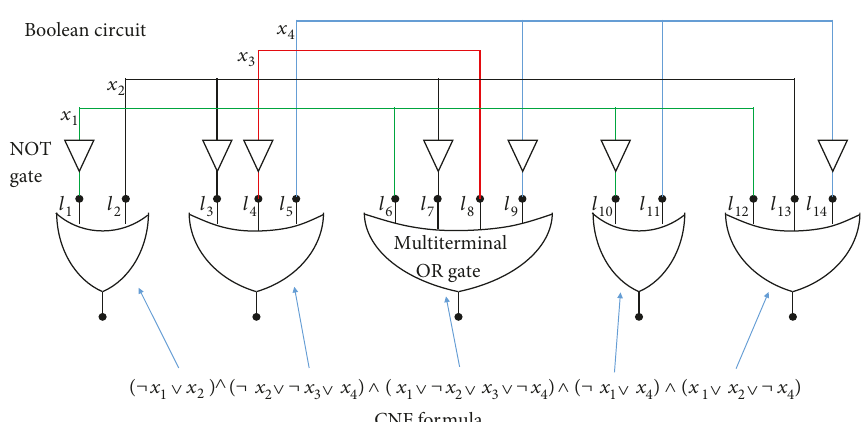
Figure 1: Example of the mapping between a Boolean satis fi ability formula in conjunctive normal form and a Boolean circuit made of multiterminal OR and NOT gates. Each clause of the SAT formula is mapped into an OR with as many terminals as the literals in the clause (the satis fi ability of this multiterminal OR requires that at least one terminal has a truth value of 1). The global optimum of the SAT formula, that is, the maximum number of satis fi ed clauses, corresponds to the maximum number of OR gates with output one. This Boolean circuit is then transformed into a self-organizing logic circuit by substituting each standard Boolean gate with a self-organizing logic gate [12], and each OR output is fed with a DC voltage generator representing the logic value of